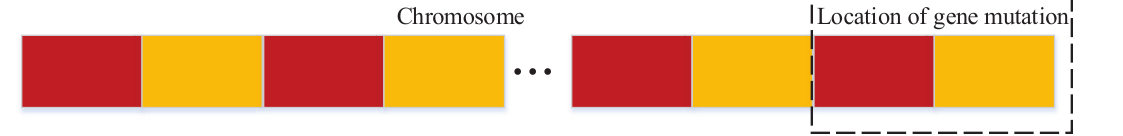
Figure 2. The description of the SPEA2